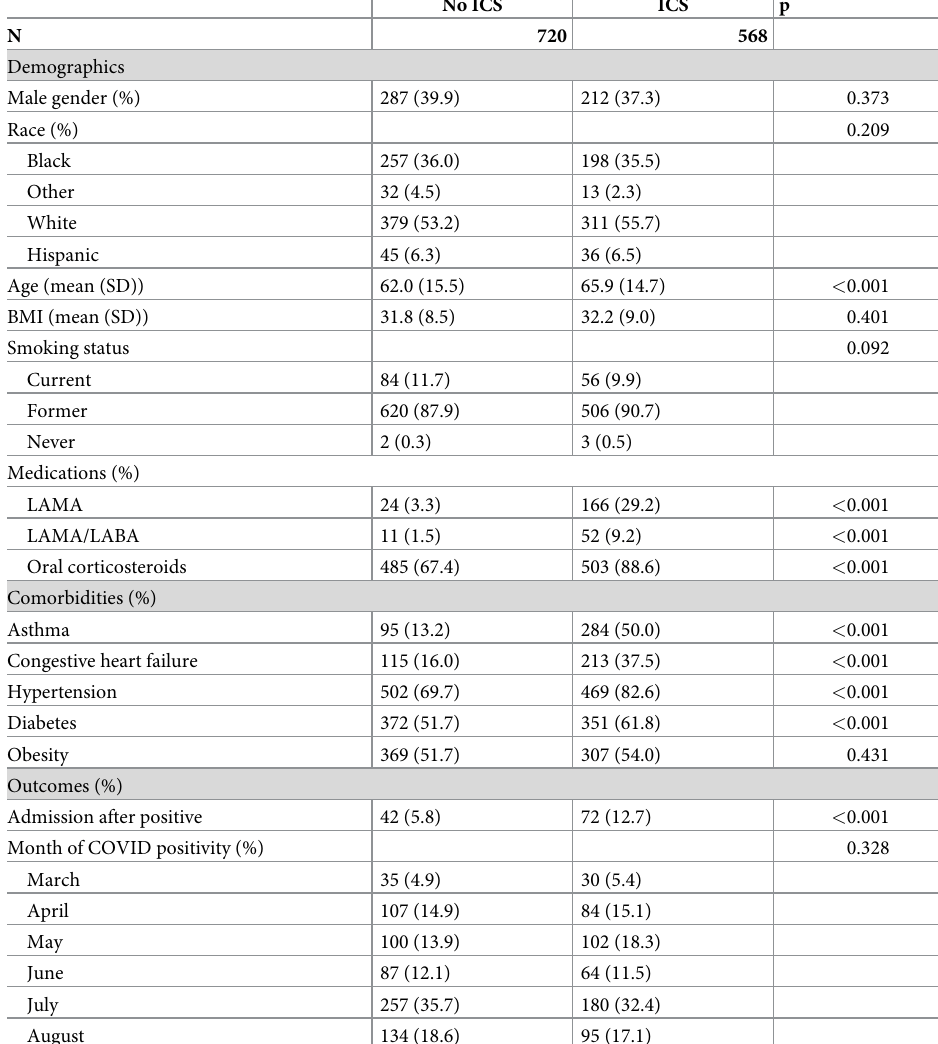
95 (17.1) Data are presented as n (%) for categorical variables and mean [SD] for continuous variables. Month of COVID positivity represents the month during which the COVID test was positive. Oral corticosteroids represent at least one course of steroids within the past year (prior to registry